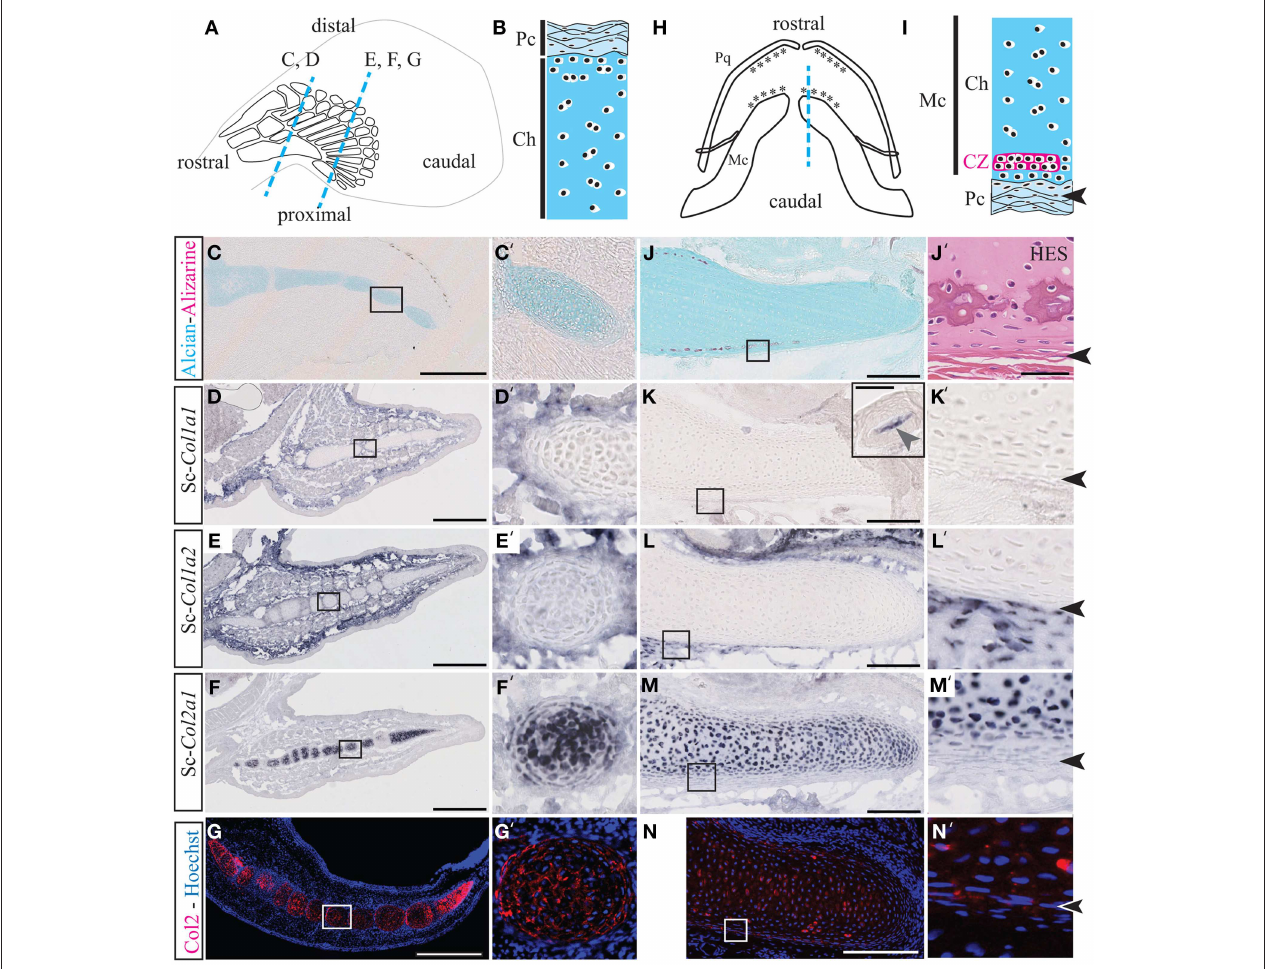
FIGURE 1 | Cartilage calcification and collagen expression in Scyliorhinus canicula radials and Meckel’s cartilage. (A) Schematic drawing of the pectoral fin anatomy from 7cm long S.c. embryos and of the orientation of the paraffin sections shown in C–G (blue dotted lines). Rostral and caudal refer to the embryonic axis. (B) General histology of pectoral skeletal elements, with the center of the cartilaginous element located at the bottom. (C,C’) Alizarin red and Alcian blue double staining. (D–F) Gene expression patterns in the pectoral fin for Sc- Col1a1 (D) , Sc- Col1a2 (E) , and Sc- Col2a1 (F) . (G) Immunofluorescence using an anti-Type II collagen (Col2) antibody specifically marks the pectoral fin cartilaginous condensations. (H) Schematic drawing of the jaw anatomy from 9cm-long S.c. embryos (ventral view) and of the orientation of the paraffin sections shown in (J–N) (blue dotted line). (I) General histology of Meckel’s cartilage, with the center of the cartilaginous element located at the top. The arrowheads in (I,J’–N’) demarcate the fibrous perichondrium from the cartilage. (J) Alizarin red and Alcian blue double staining. (J’) Higher magnification of a tesserae located in a similar region as the area boxed in (J) and stained with HES. (K–M) Gene expression patterns in the jaw for Sc- Col1a1 [the inset in ( K) shows a Sc- Col1a1 positive dermal denticle from the same section], Sc- Col1a2 (L) and Sc- Col2a1 (M) . (N) Immunofluorescence using an anti-Type II collagen (Col2) antibody specifically marks the cartilaginous condensations of Meckel’s cartilage. Insets in (C–N) are shown at higher magnification in (C’–N’) , respectively. CZ, calcification zone of the tesserae; Ch, chondroctyces; Fb, fibroblasts; Pc, perichondrium; Pq, palatoquadrate. Scale bars: (C–G) , 250 µ m; (J–N) , 100 µ